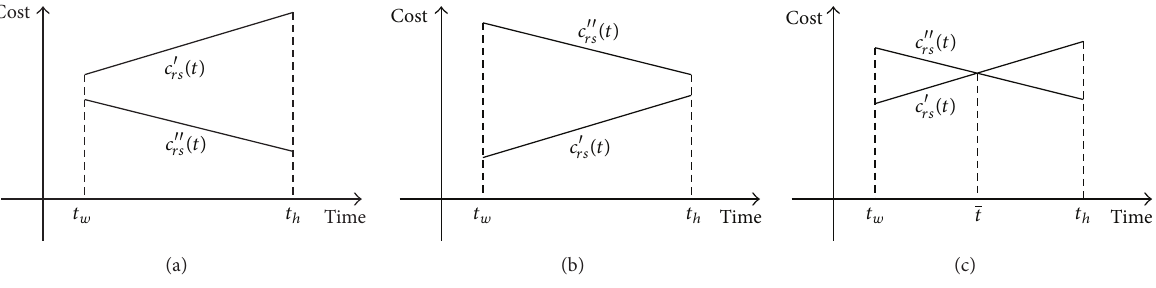
Figure 3: The change relation of 𝑐 󸀠󸀠 𝑟𝑠 (𝑡) and 𝑐 󸀠 𝑟𝑠 (𝑡) with time 𝑡 .